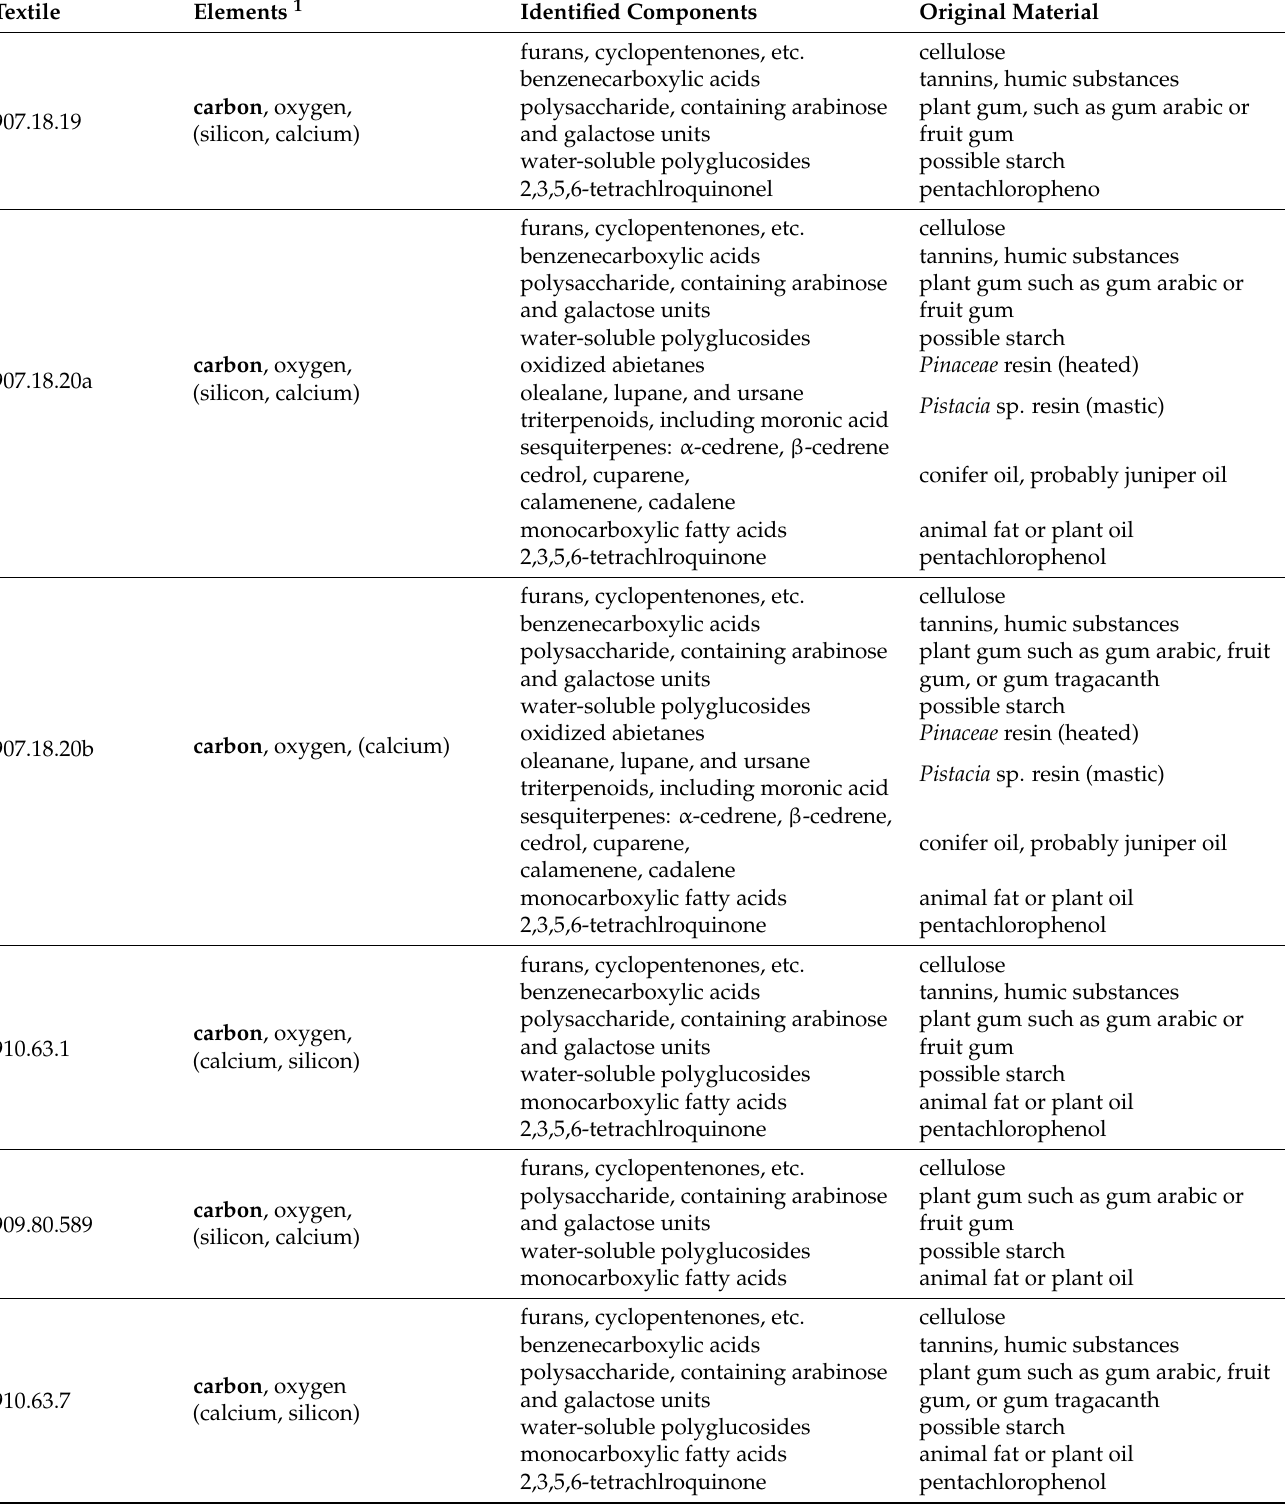
Table 3. Analytical